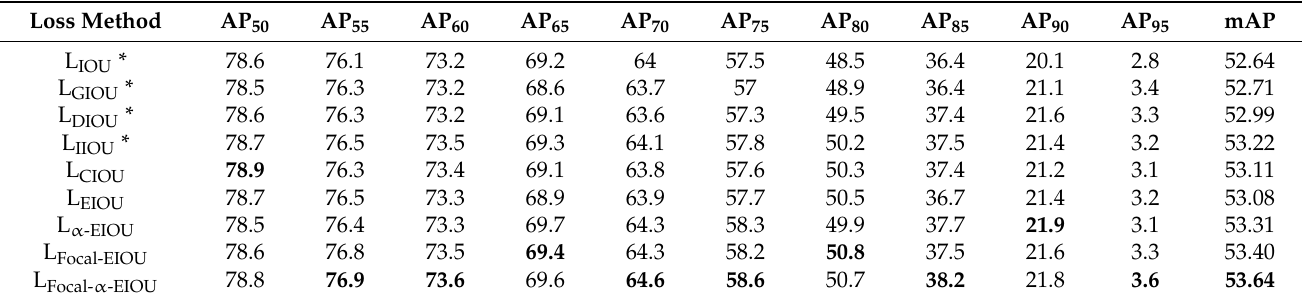
Table 4. PASCAL VOC2007 test detection results. mAP denotes mAP 50:95 .